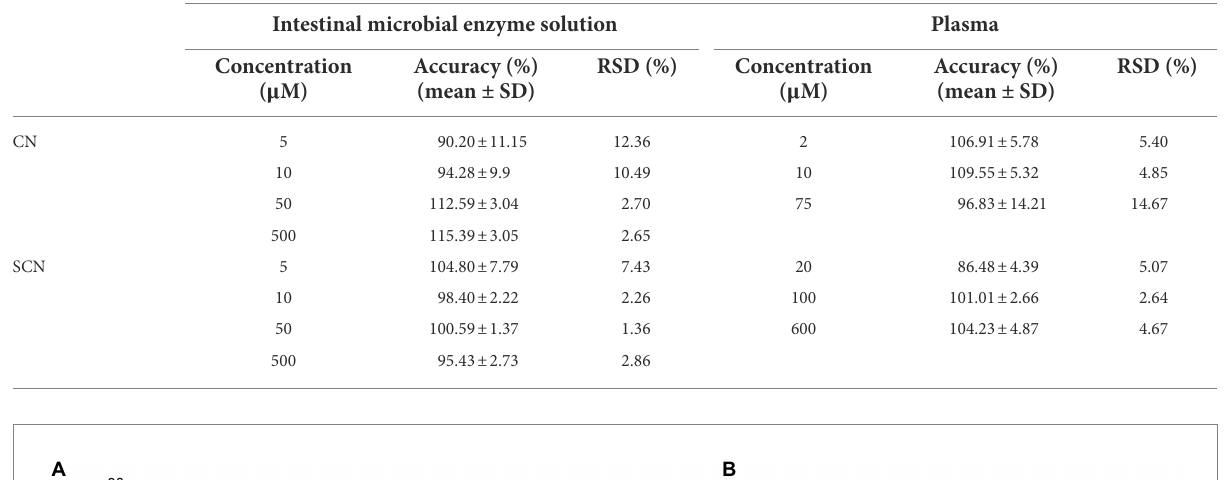
TABLE 2 Accuracy of CN and SCN in intestinal microbial enzyme solution and plasma ( n = 6). Analytes